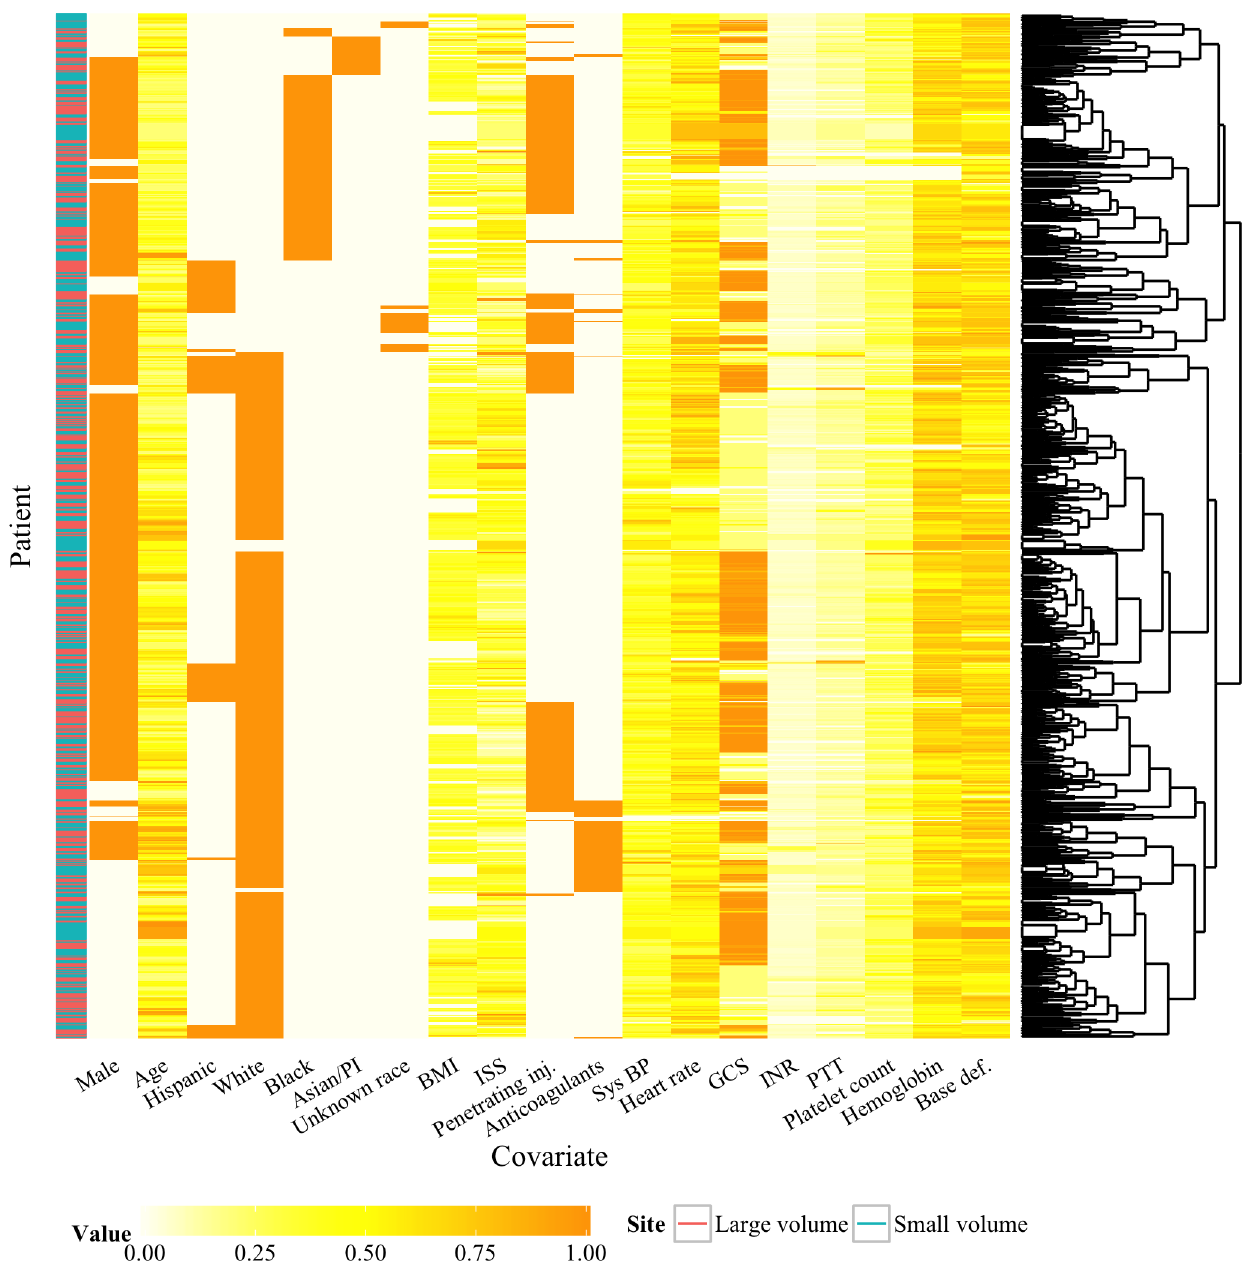
Fig 2. Heatmap of matched data set with hierarchical clustering. A visualization of the scaled covariate values in the matched data set with hierarchical clustering of the individual revealed little clustering of the individuals by site type, indicated in the bar on the left, suggesting that balance in the covariates was achieved. The dendrogram on the right is the result of hierarchical clustering of the individuals based on their covariate values. The color bar on the left indicates the site size where each individual was treated (purple corresponds to small-volume sites and blue to large-volume sites).